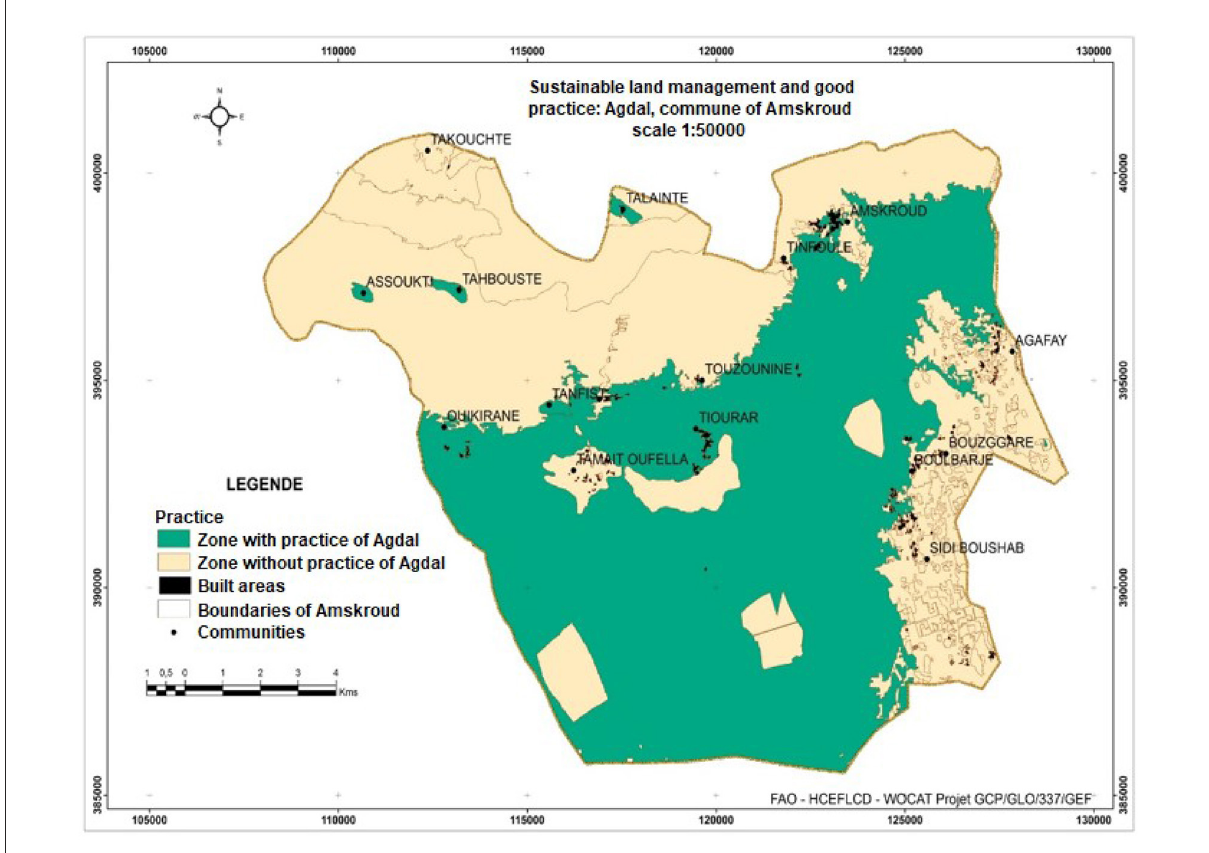
FIGURE13 Areas with and without agdal practice within the Amskroud commune.